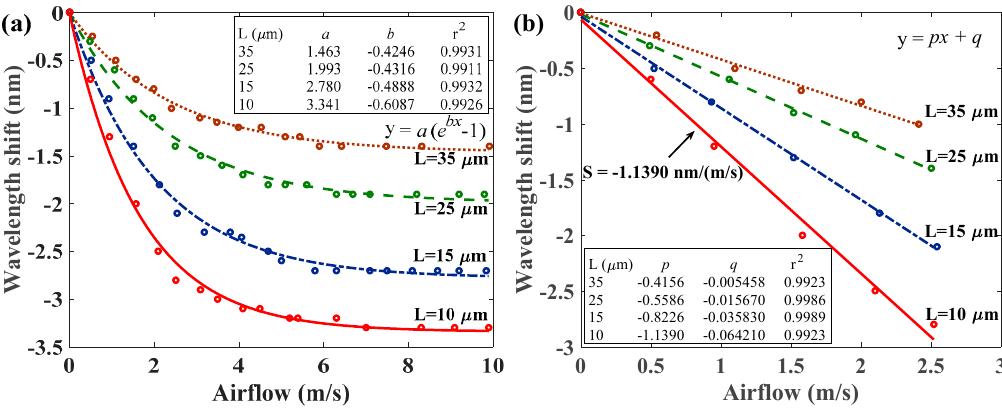
Figure 8. ( a ) Wavelength shifts of interference spectra of different HPFFPIs under airflows of various speeds when the hot polymer is initially heated with an input power of 0.402 W. ( b ) Measured sensitivities with linear responses at low airflow speed for different HPFFPIs (below 2.54 m/s).